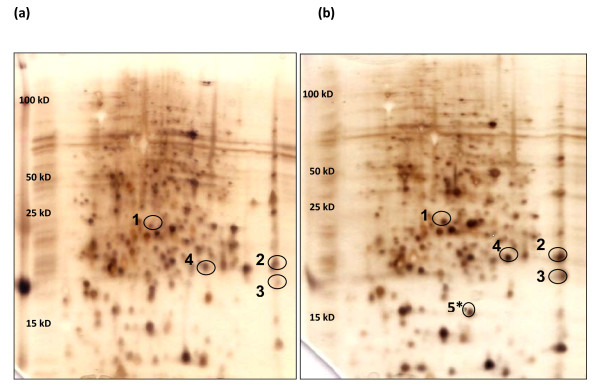
2 D gel images of the soluble protein fractions from PA adapted and unadapted S. Enteritidis cultures. (a) Unadapted gel, (b) PA adapted gel. Proteins upregulated in PA gel selected for further examination are circled. Proteins restricted to PA adapted gels are designated with an asterisk (*) in gel (b). Labeled Proteins were identified as (1) CpxR, (2) RplE, (3) RplF, (4) SodA, (5) Dps.